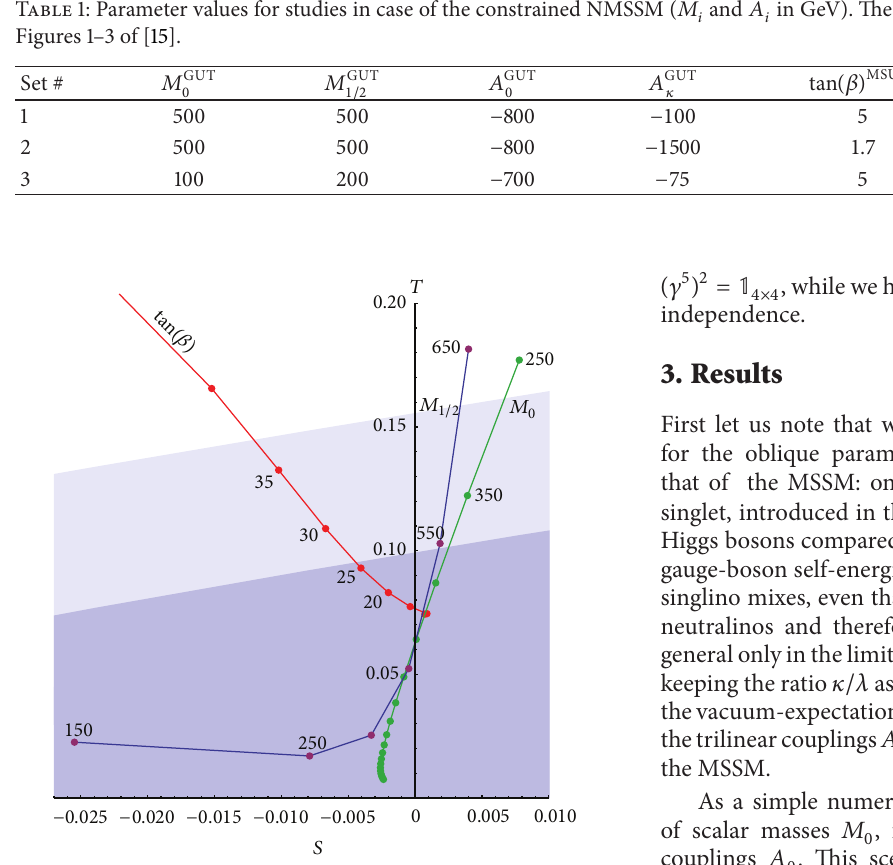
Figure 1: Oblique parameters 𝑆 and 𝑇 in the NMSSM in the constrained case with central parameters tan (𝛽) = 5 , 𝑀 0 = 𝑀 1/2 = = −800 GeV, 𝐴 = −100 GeV, sgn (𝜇) = + , and 𝜆 = 0.15 500 GeV, 𝐴 0 𝜅 (first row of Table 1) with variation of the parameters successively in the ranges tan (𝛽) = 5, 10, .. ., 40 (tan (𝛽) = 5,10 lie very close together), 𝑀 0 = 250 GeV, 350 GeV, . . . ,1950 GeV, 𝑀 1/2 = 150 GeV, 250 GeV, . . . ,650 GeV as indicated in the figure. The shaded regions show the 1𝜎 and 2𝜎 error ellipses of the electroweak precision measurements fitted to 𝑆 and 𝑇 corresponding to (3)